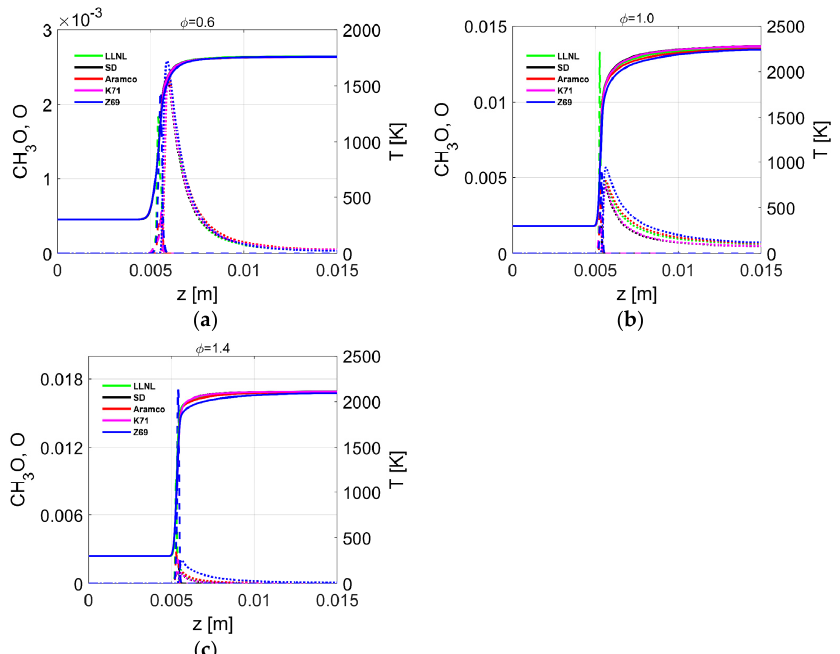
Figure A5. Flame profiles showing the flame temperature (solid line) and minor species concentra- tions, CH 3 O (dashed line) and O (dotted line), at standard conditions of 1 atm and 300 K. The values for CH 3 O have been timed by 200 in order to be easier to read. Three equivalence ratios are shown with φ = 0.6 in ( a ), φ = 1.0 in ( b ) and φ = 1.4 in ( c ). Legend: mechanism predictions from Z69 in blue, LLNL in green [28], Aramco in red [17], K71 in magenta [32] and San Diego in black